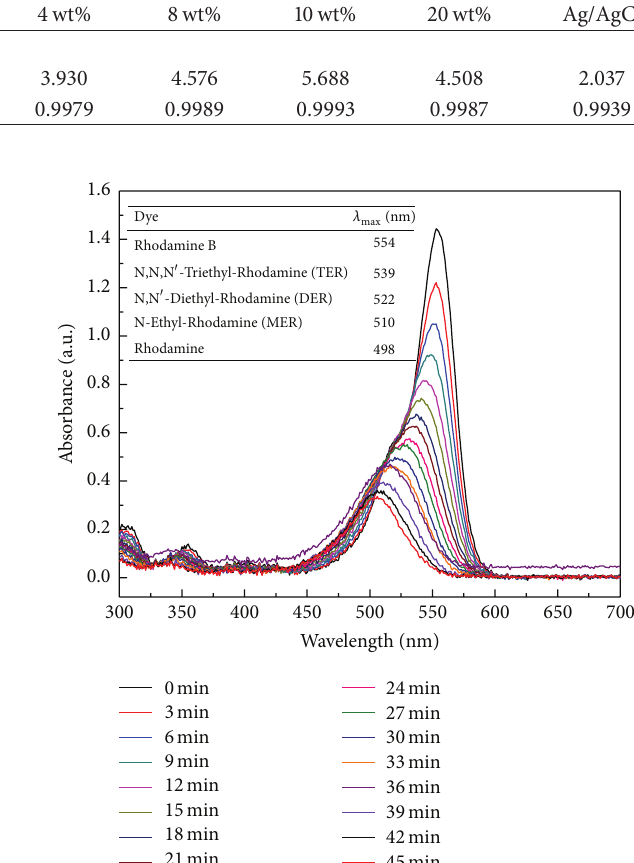
Figure 10: UV-Vis spectra of solutions taken during the photocat- alytic process in the presence of Ag/AgCl (10wt%)-Bi 2 WO 6 (inset table shows characteristic wavelength for each intermediate species in water